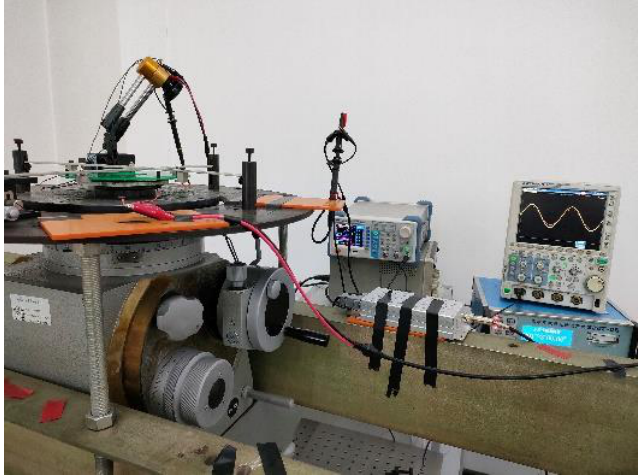
Figure 11. Test platform of inductosyn.